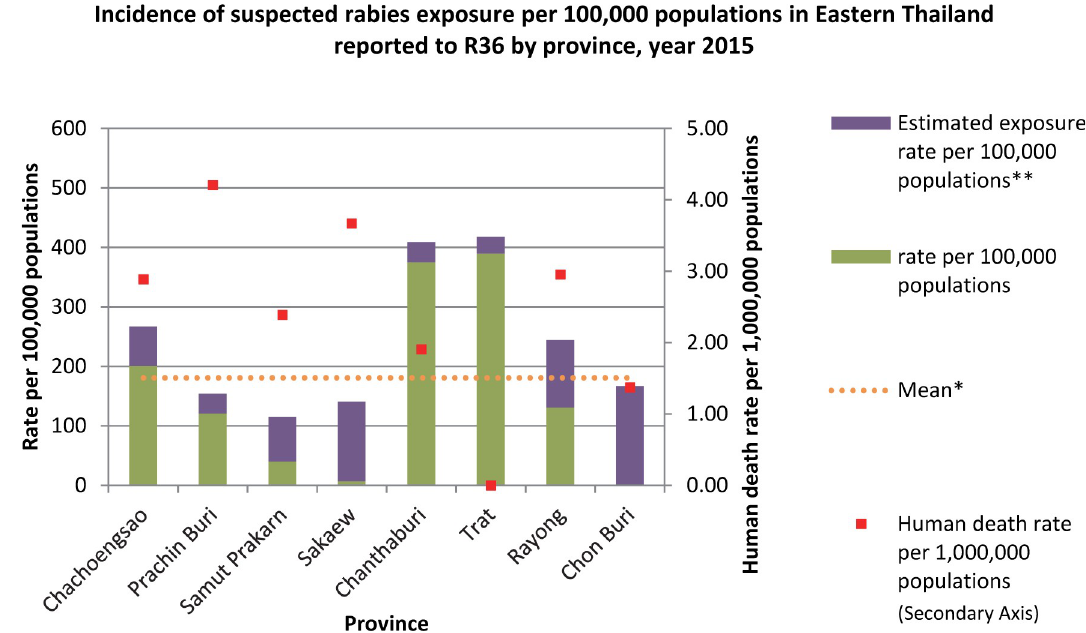
Fig 2. Incidence of suspected rabies exposure per 100,000 population in 8 Eastern Thailand provinces reported to R36 between 1 st Jan– 31 st Dec 2015. Note : � Crude mean; �� Estimation of suspected rabies exposure rate per 100,000 populations with full participation from predicted linear